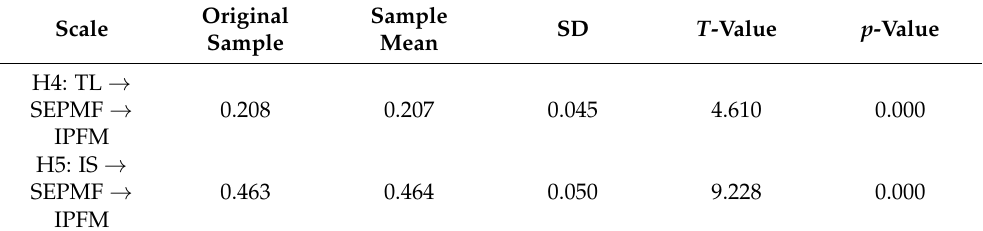
Table 5. Specific indirect effects.